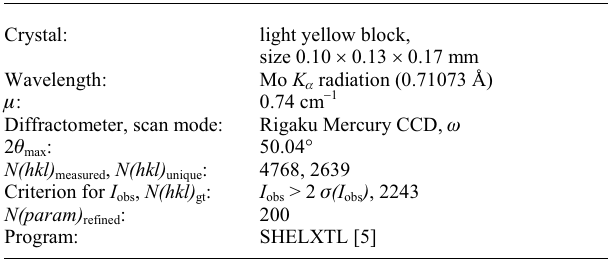
Table 1. Data collection and handling.